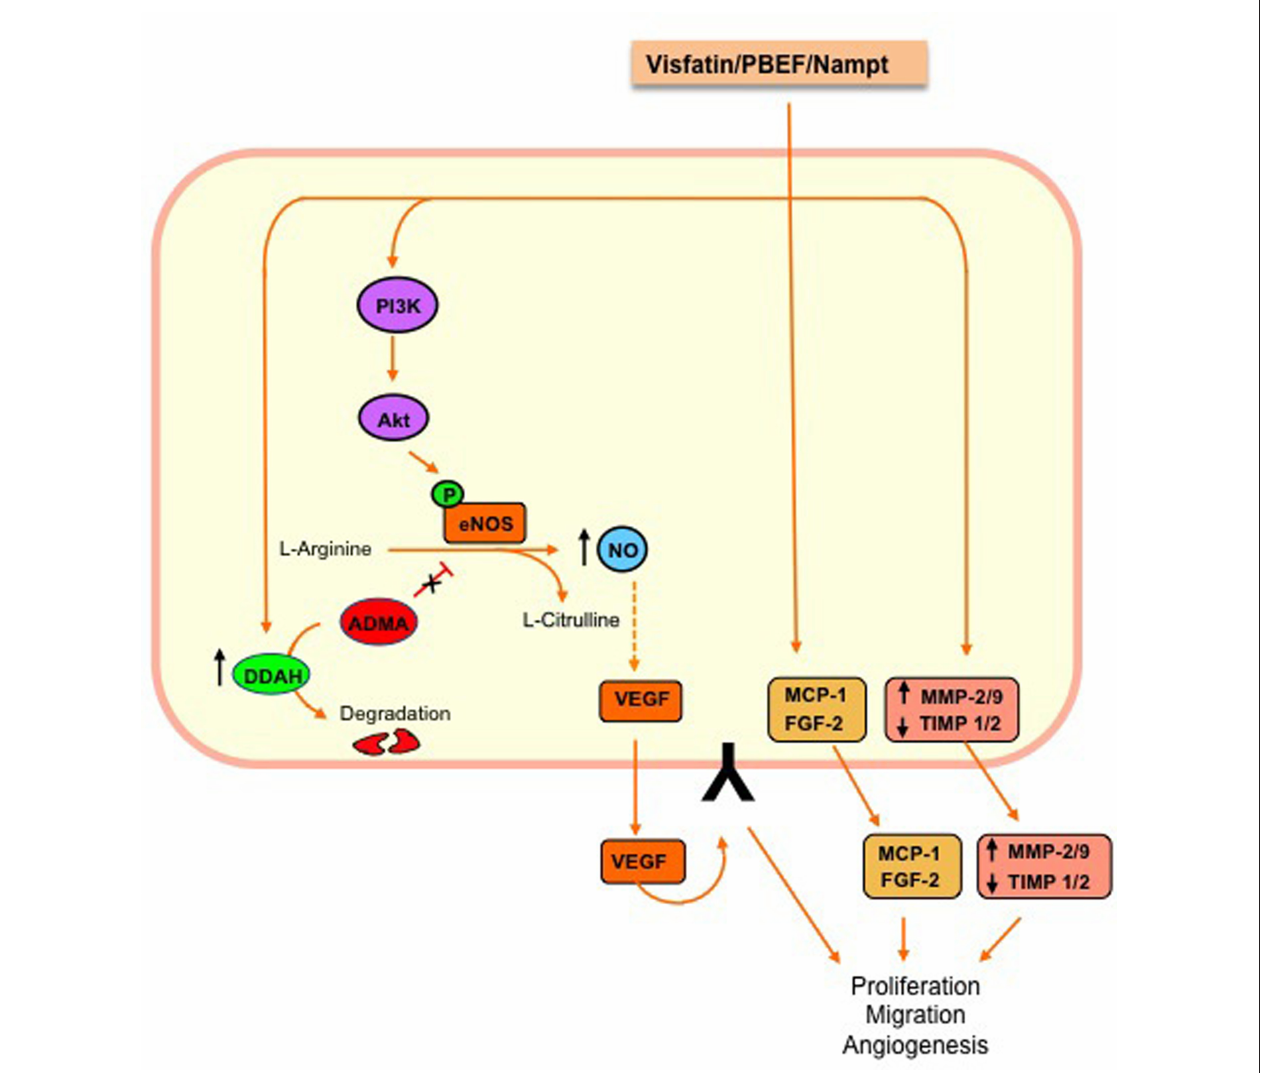
dimethylarginine dimethylaminohydrolase (DDAH), which degrades the eNOS inhibitor asymmetric dimethylarginine (ADMA). Additionally, visfatin/PBEF/ Nampt triggers the endothelial production of other pro-angiogenic molecules, such as monocyte chemoatractant protein (MCP)-1 and fibroblast growth factor (FGF)-2. On the other hand, visfatin/PBEF/Nampt enhances the levels and activation of matrix metalloproteinases (MMP)-2/9 while decreasing the levels of tissue inhibitor of metalloproteinases